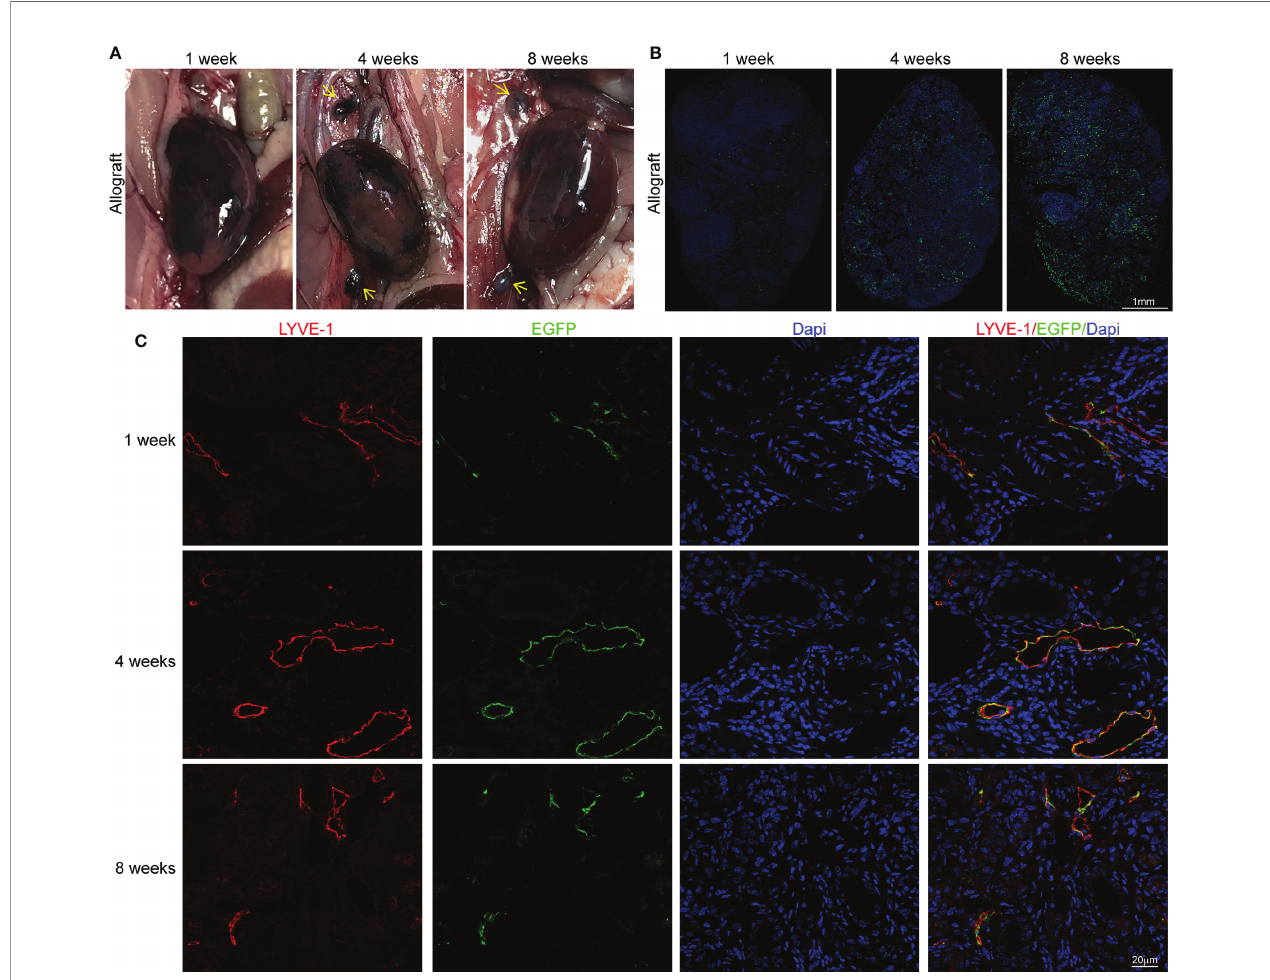
FIGURE 3 | Determination of the reconnection and origin of LVs (A) Staining of renal draining lymph nodes (yellow arrows) after the injection of Evans Blue under renal capsule in sham (n=6 mice), isograft (n=6 mice), and allograft (n=6 mice) groups at 1, 4 and 8 weeks respectively. (B) Representative immuno fl uorescence images showing the dendritic cells separated from peripheral blood of Itgax-Cre-GFP mice in renal draining lymph nodes after injection of these cells under the renal capsule at the 1st, 4th, and 8th week after surgery. Scale bar represents 1 mm. (C) Co-localization of LYVE-1 + and EGFP + cells to explore the donor or recipient origin of lymphatic vessels at 1, 4 and 8 weeks respectively. Scale bar represents 20 m